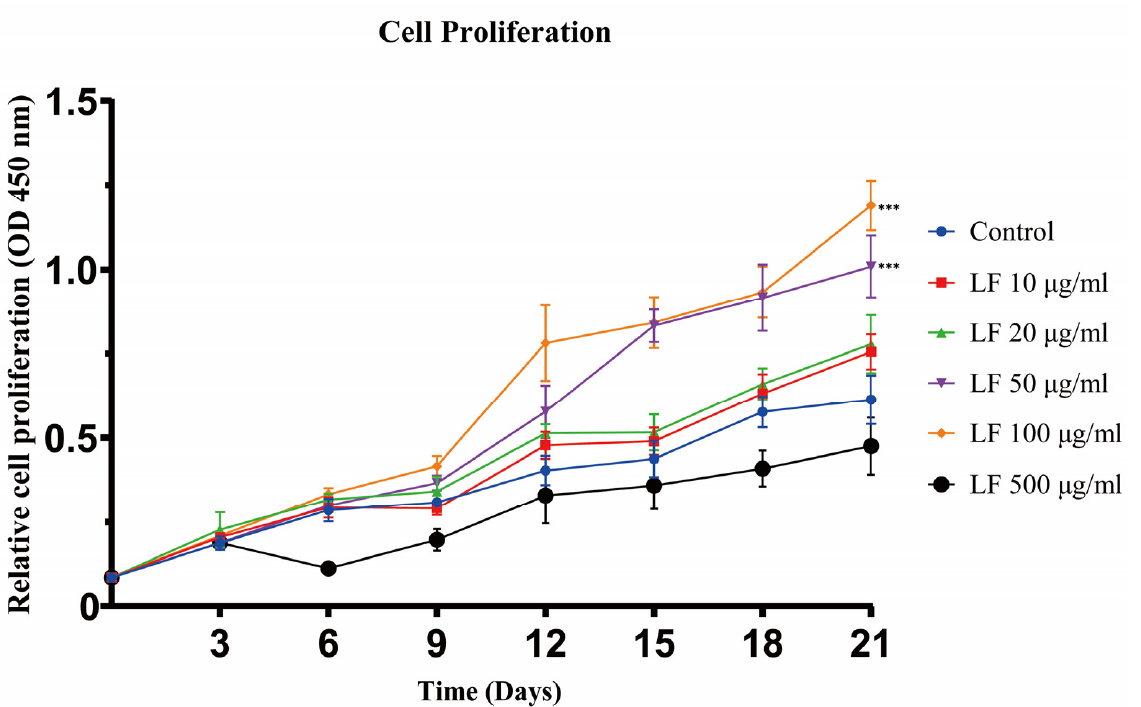
Figure 1. Cell proliferation assay of ADSCs cultured under different LF concentrations was analyzed on days 3, 6, 9, 12, 15, 18, and 21. LF promoted the proliferation of hADSCs at 10~100 μ g/mL. Proliferation was inhibited by 500 µ g/mL LF. Values are presented as means ± SE, *** p < 0.001. The observed ALP-stained ADSCs in LF groups were concentration-dependent.